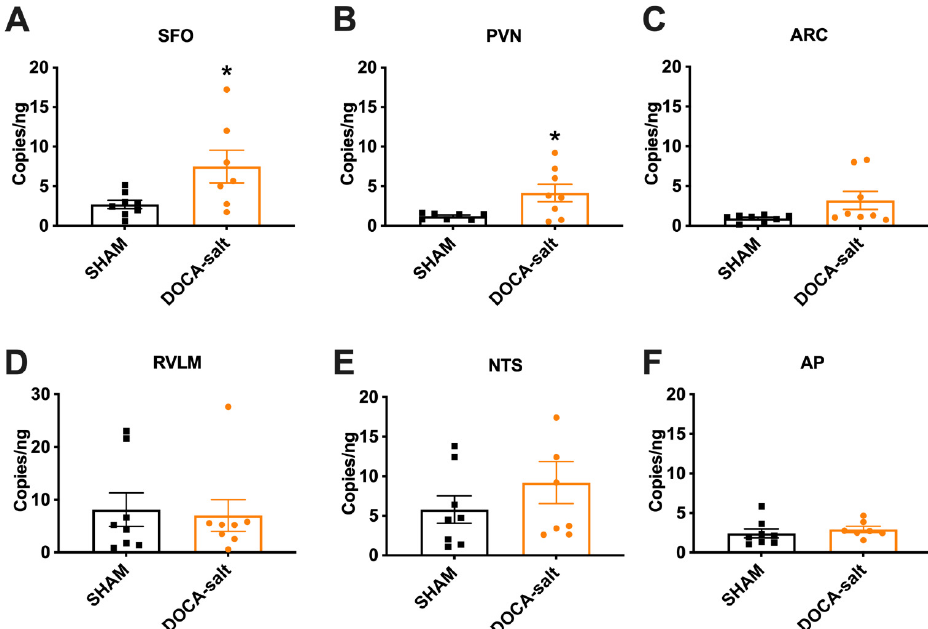
Figure 1. Renin mRNA is upregulated in the SFO and PVN of DOCA-salt–treated mice. ( A – F ) Total renin levels were detected in the subfornical organ (SFO), paraventricular nucleus of hypothalamus (PVN), arcuate nucleus (ARC), rostral ventrolateral medulla (RVLM), nucleus tractus solitarius (NTS), and area postrema (AP) using ddPCR. * p < 0.05 versus sham treatment (Student’s t test); n = 7–9 mice/group.